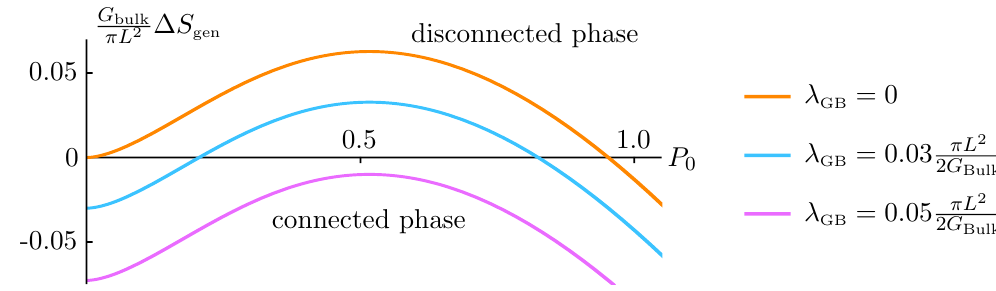
Figure 10 . Renormalised entropy from eq. (4.52). The connected (disconnected) surface dominates when (cid:1) S < 0 ((cid:1) S > 0). When (cid:21)